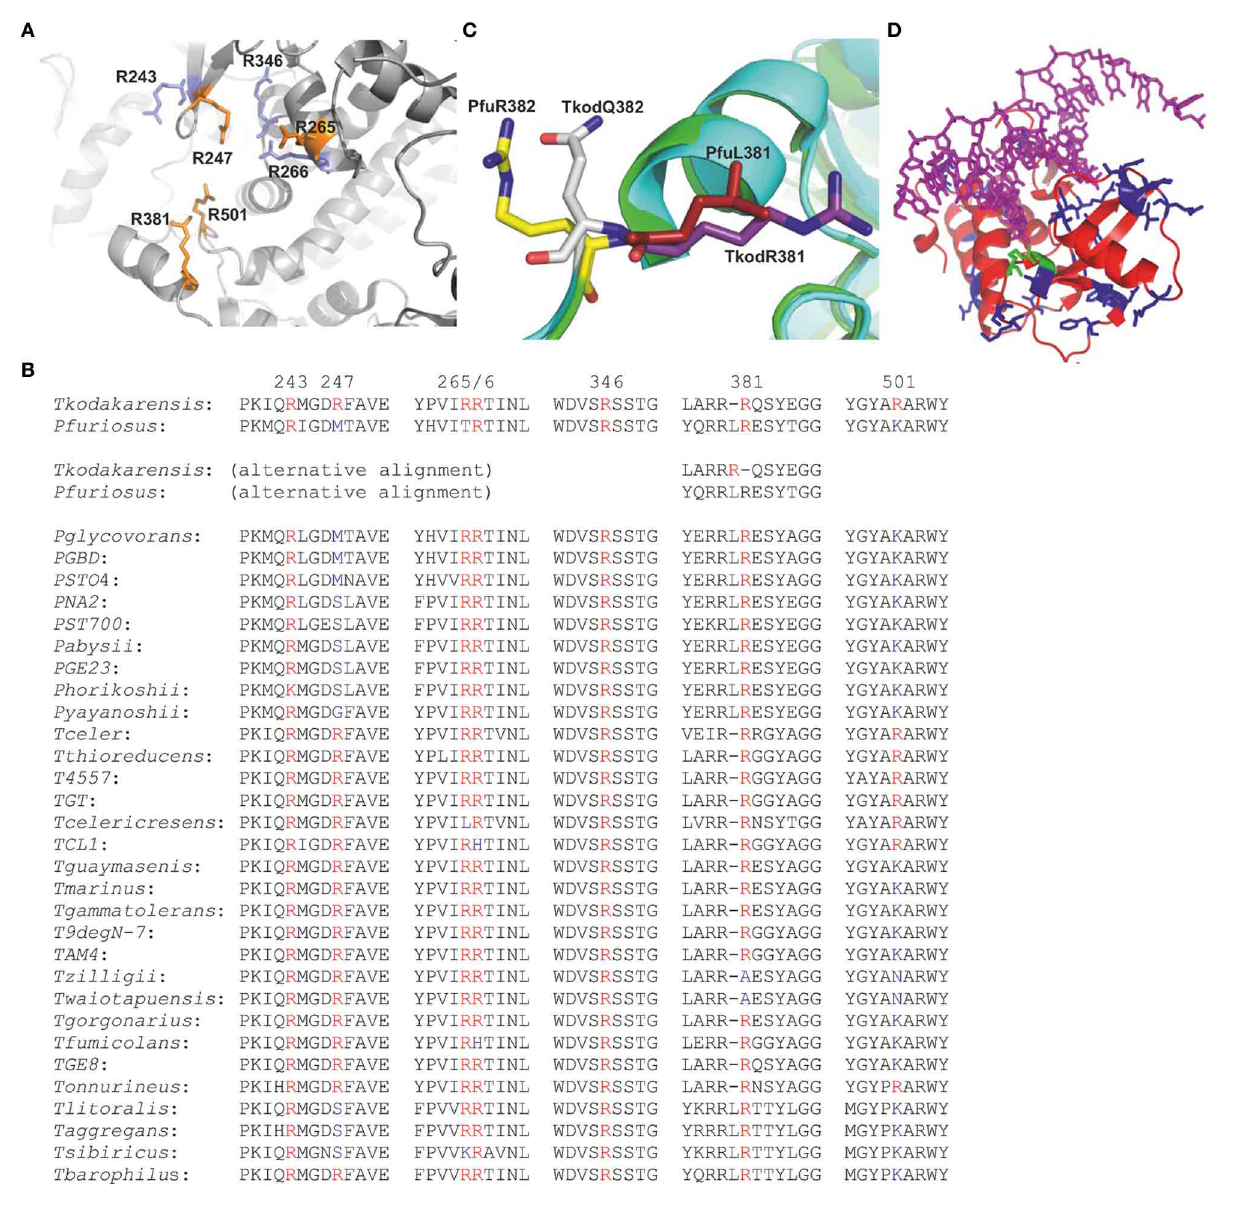
amino acid is shown in blue. As discussed in the text, the insertion/deletion at amino acid 381 allows for two alternative alignments. For the species list, T = Thermococcus , P = Pyrococcus . (C) Superimposition of the Tkod-Pol (main chain in blue) (pdb; 1GCX) and Pfu-Pol (main chain in green) (pdb; 2JGU) near arginine 381. The overlay clearly shows that the spatial equivalent of Tkod-Pol R381 (purple) is Pfu-Pol L381 (red), rather than Pfu-Pol R382 (yellow) which is near Tkod-Pol Q382 (gray). (D) Thumb domain of Tkod-Pol bound to DNA in a polymerization mode (pdb; 4K8Z). The amino acids that are different in Pfu-Pol are shown in blue (no direct contact to DNA) or green (direct contact to